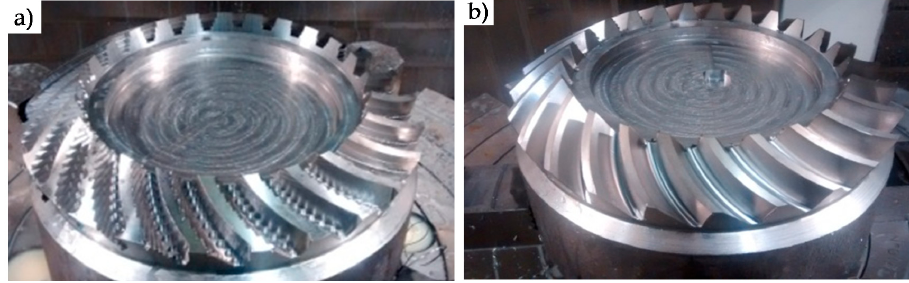
Figure 4. Roughing strategies result ( a ); Finishing strategies result ( b ).